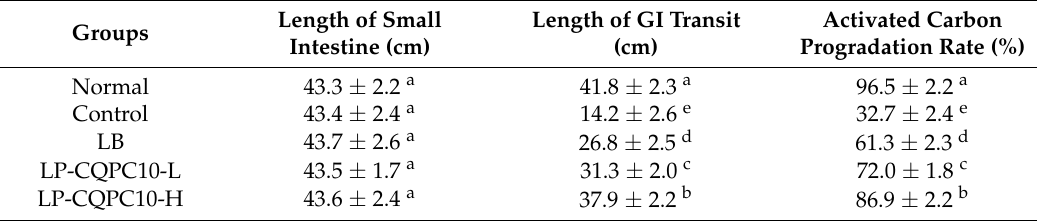
Length of GI Transit Activated Carbon (cm)